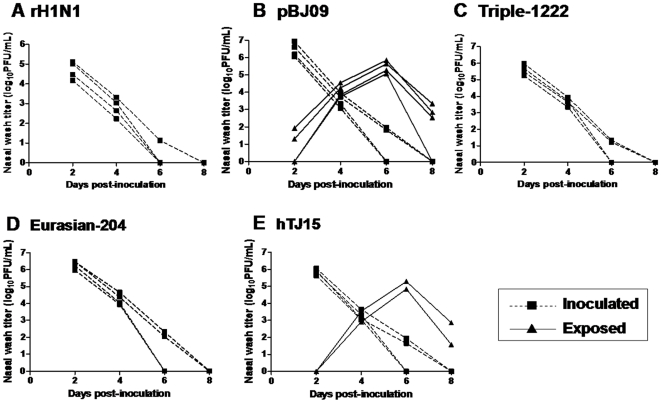
Contact transmission of rH1N1 (A), pBJ09 (B), Triple-1222 (C), Eurasian-204 (D) and hTJ15 (E) viruses in guinea pigs.Four guinea pigs were intranasally inoculated with 104.0 PFU of virus and each animal was housed in a separate cage. At 24 h p.i., a naïve guinea pig was placed in the same cage with each inoculated guinea pig. Virus titers in nasal washes were plotted as a function of time post-inoculation. Titers of intranasally inoculated animals are represented by dashed lines and solid squares; virus titers of exposed guinea pigs are shown with solid lines and solid triangles. The limit of virus detection was 10 PFU/mL.